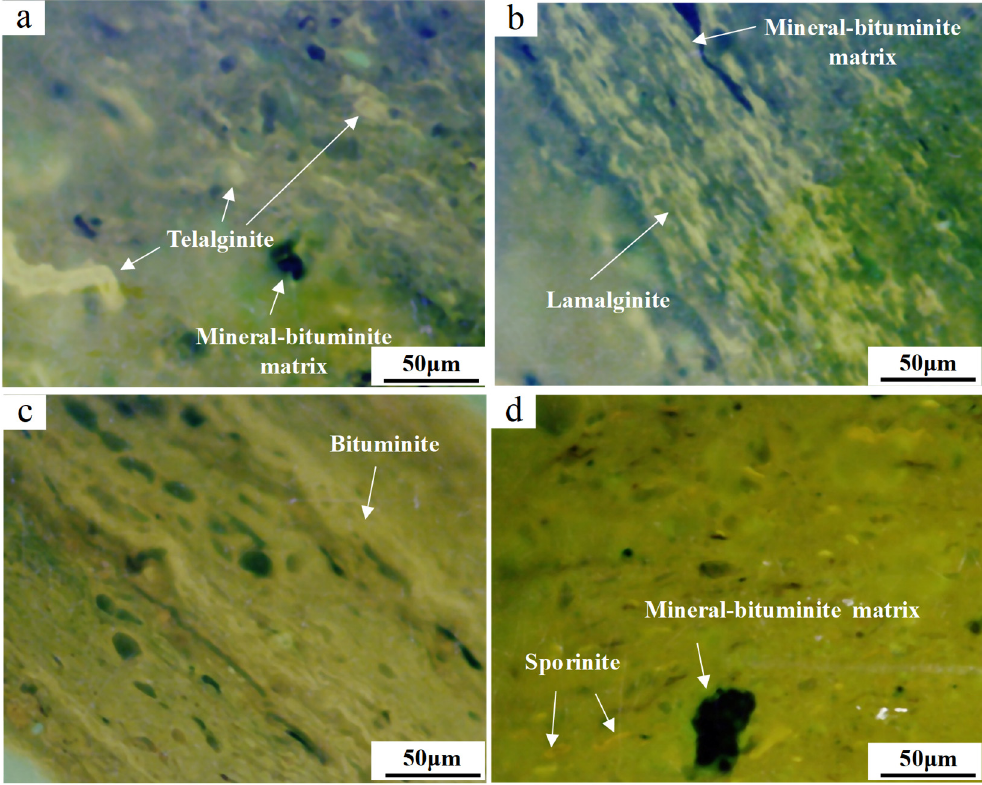
Figure 7. Photomicrographs showing maceral groups of the Es4 source rocks in the Niuxintuo area. ( a ) Brightly fluorescent telalginite and mineral–bituminite matrix, 1450 m, mudstone, ×500. ( b ) Brightly fluorescent lamalginite and mineral–bituminite matrix, 1430 m, mudstone, ×500. ( c ) Bituminite, 1200 m, mudstone, × 500. ( d ) Sporinite and mineral–bituminite matrix, 1200 m, mudstone, × 500.